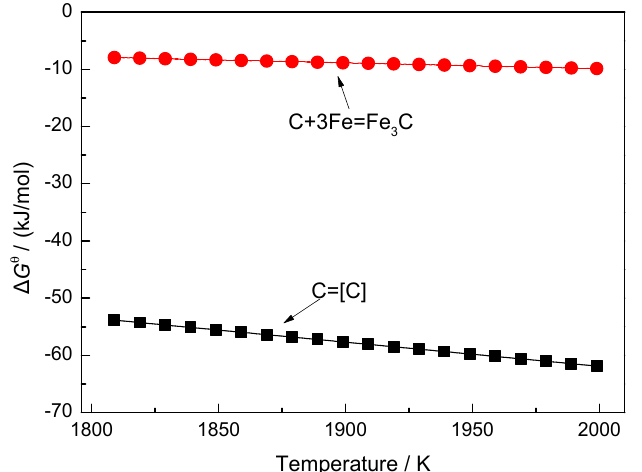
Figure 15. Variation of the standard Gibbs free energy of carburizing reactions with temperature.